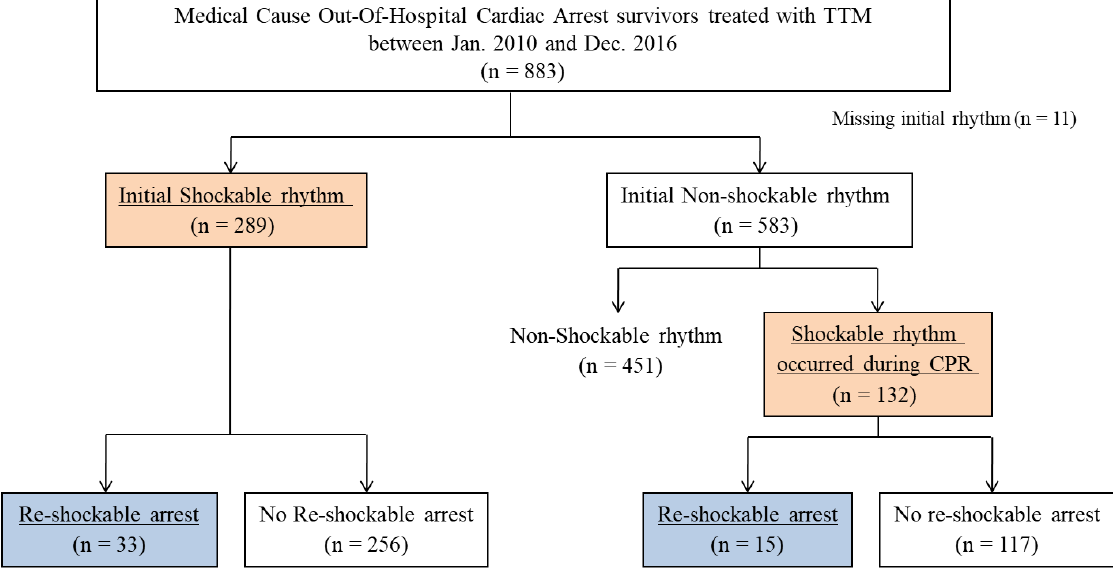
Table 2. Baseline characteristics and cardiopulmonary resuscitation profiles between patients with non-shockable re-arrest and shockable re-arrest.